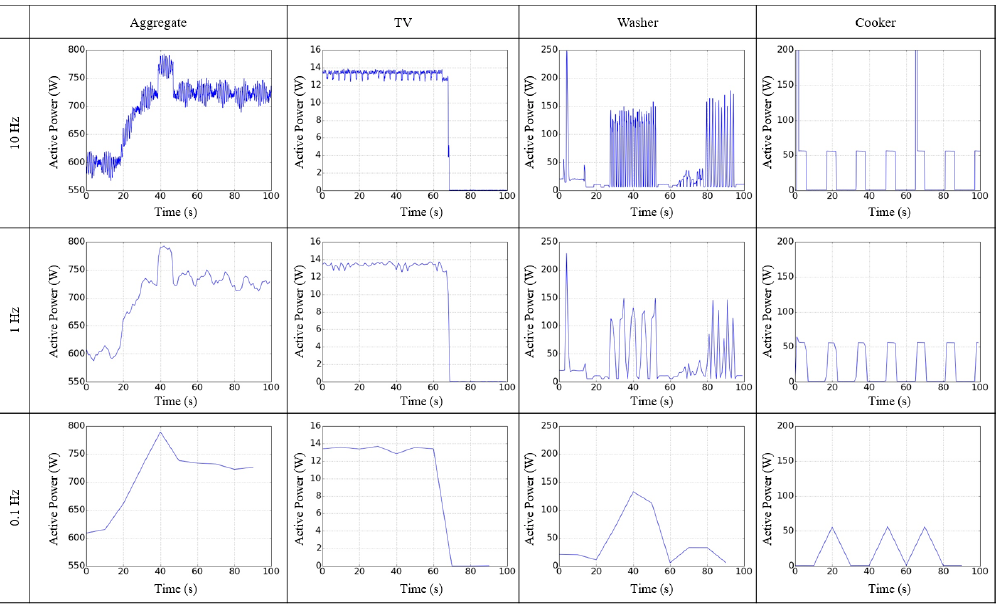
Figure 3. Electricity signal shapes (signatures) of aggregate, TV, washer, and rice cooker for 10, 1, and 0.1 Hz sampling.